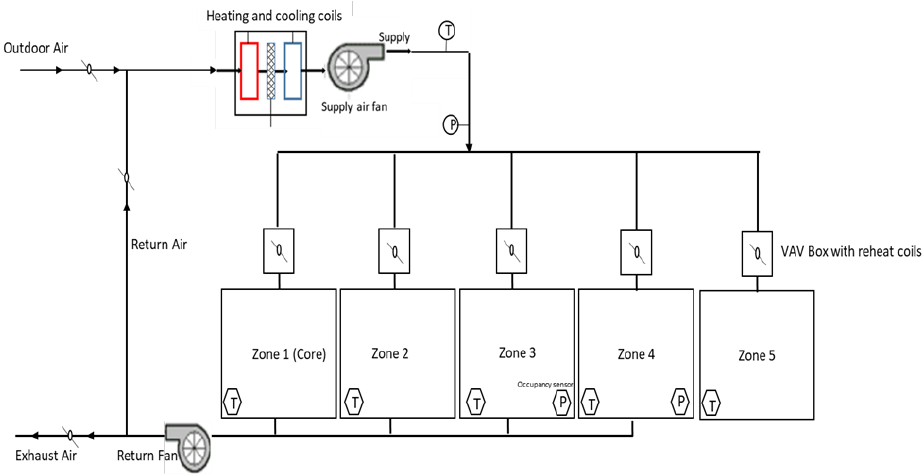
Figure 7. The layout of the packaged VAV unit that serves each five zones.